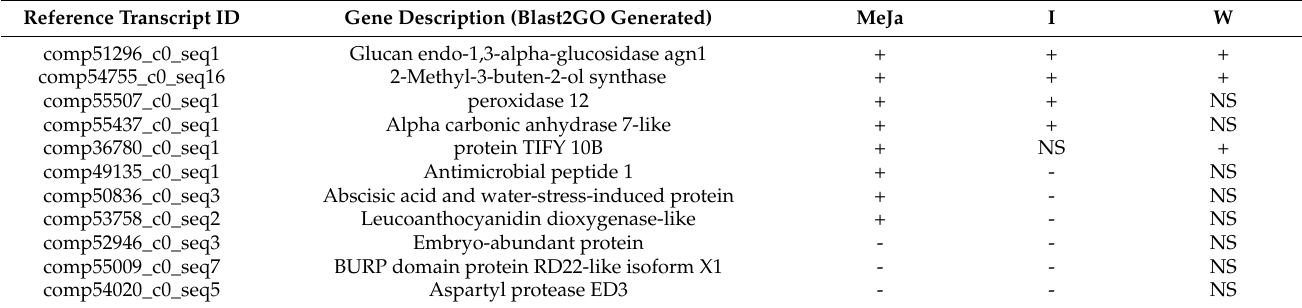
Table 12. Regulation of the overlapping DEGs of the MeJa and inoculation/wounding experiments.